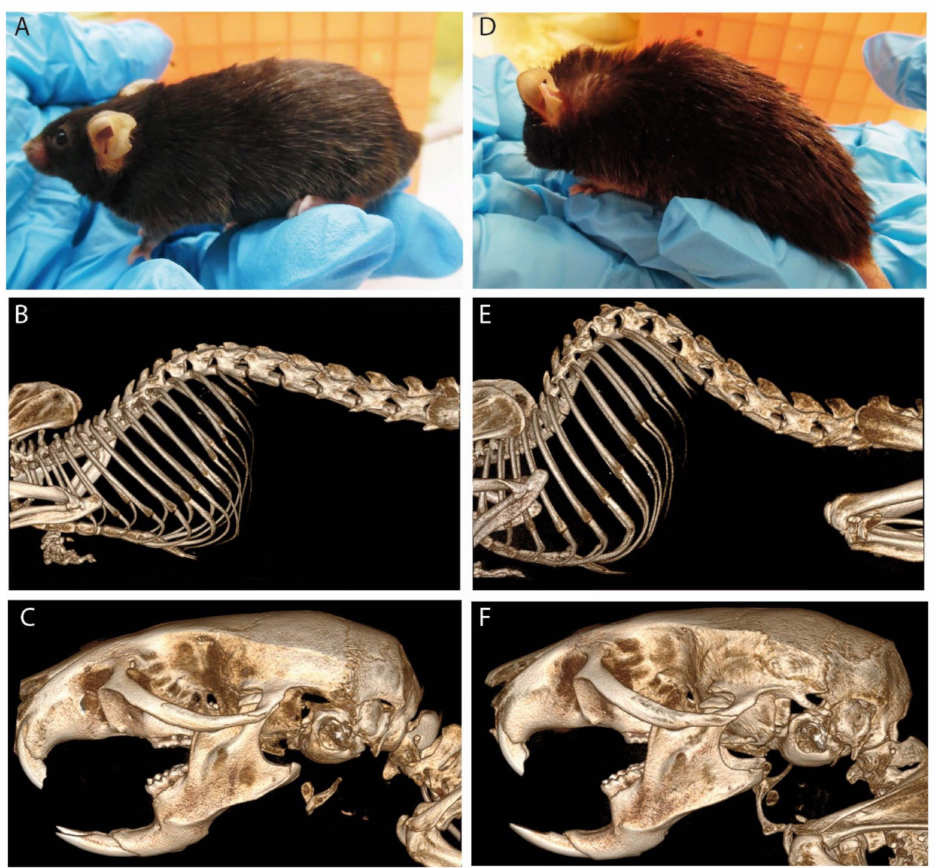
Figure 4. Phenotype of an ACBD5-deficient mouse line. ( A ) General body morphology of a 1-year-old wild type mouse compared to ( D ) an ACBD5-deficient mouse, which exhibits a prominent kyphosis in the thoracolumbar spine. Computer tomography (CT) analysis of the bone morphology revealed no obvious skeletal malformations in vertebrae of ACBD5-deficient mice ( E ) compared to wild type mice ( B ). Likewise, other bone structures (e.g., bones of the skull) show a comparable morphology in wild type ( C ) and ACBD5-deficient mice ( F ). Hence, the pathological kyphosis is not caused by compromised bone development but is of a secondary nature. As the animals also show a motor phenotype and degeneration of cerebellar Purkinje cells, the kyphosis is most likely caused by a compromised spinocerebellum inducing an imbalance in the contraction of flexor and extensor trunk